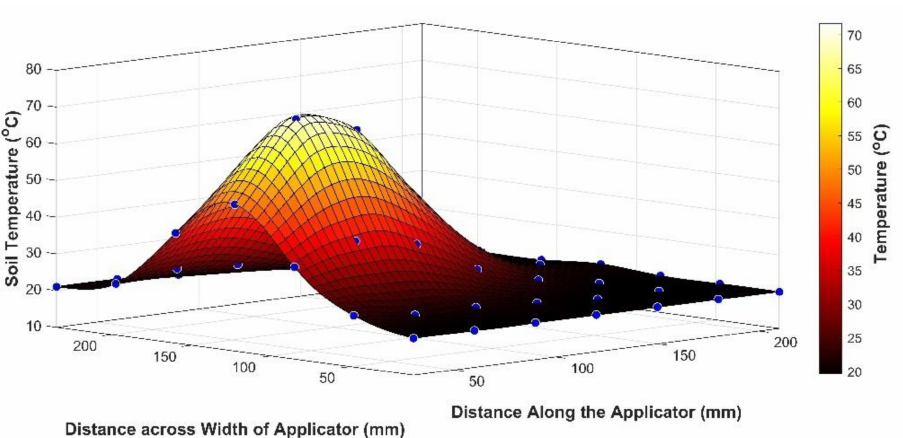
Figure 5. Temperature distribution in the soil at 10 mm depth produced by the comb slow-wave applicator (F = 2.45 GHz, p = 3.5 kW, time of MW heating 15 s, T o = 20 ◦ C, applied energy 52.5 kJ. Soil moisture content MC = 89%, density = 710 kg m − 3 ).